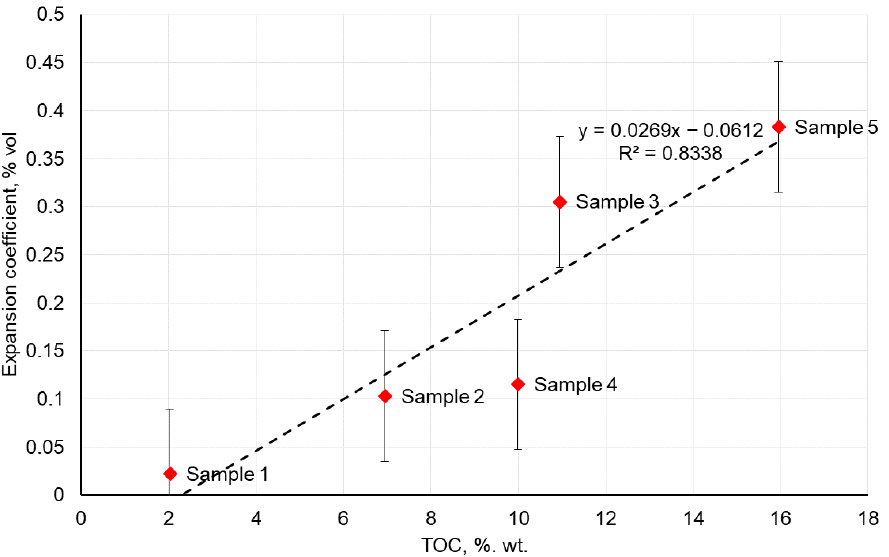
Figure 11. Cross-plot for the volumetric expansion coefficient and TOC in the swelling experiments with supercritical CO 2